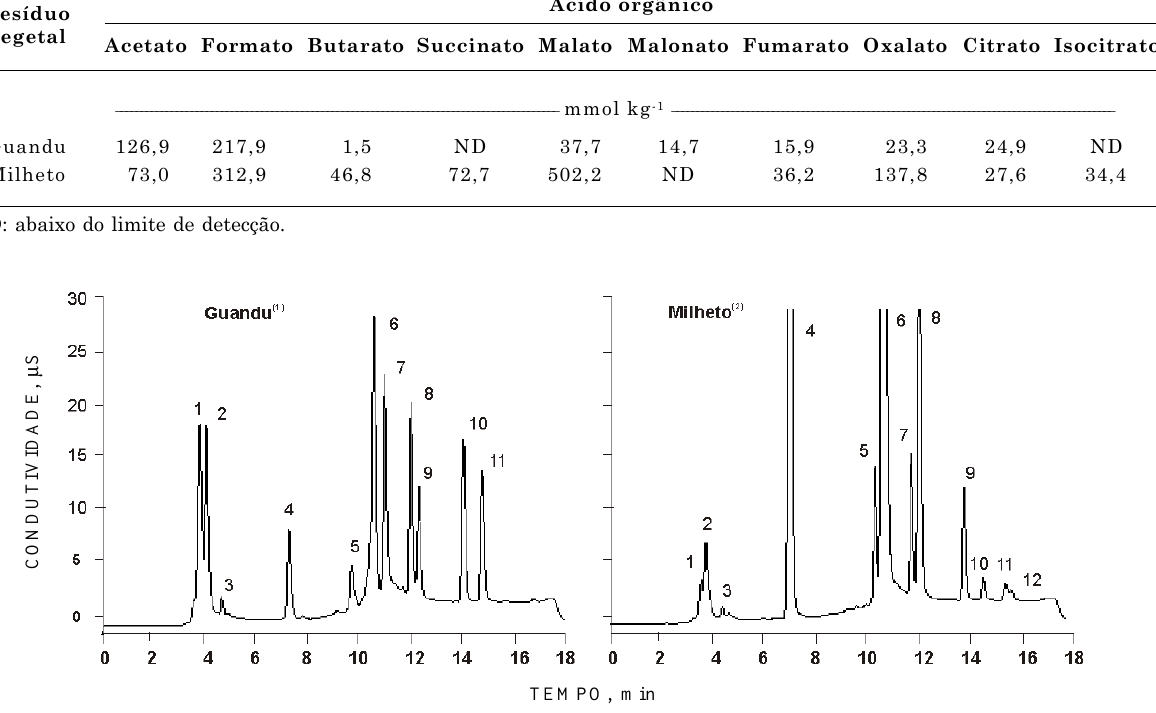
Figura 3. Cromatogramas demonstrando a presença de ácidos orgânicos e ânions inorgânicos nos extratos vegetais de guandu e milheto. Guandu: 1. acetato, 2. formato, 3. butarato, 4. cloreto, 6. malato, 7. malonato, 8. fumarato, 9. oxalato, 10. fosfato, 11. citrato; Milheto: 1. acetato, 2. formato, 3. butarato, 4. cloreto, 5. succinato, 6. malato, 7. fumarato, 8. oxalato, 9. fosfato, 10. citrato, 12. isocitrato. (1) Fator de diluição: 10 vezes; (2) Fator de diluição: 20